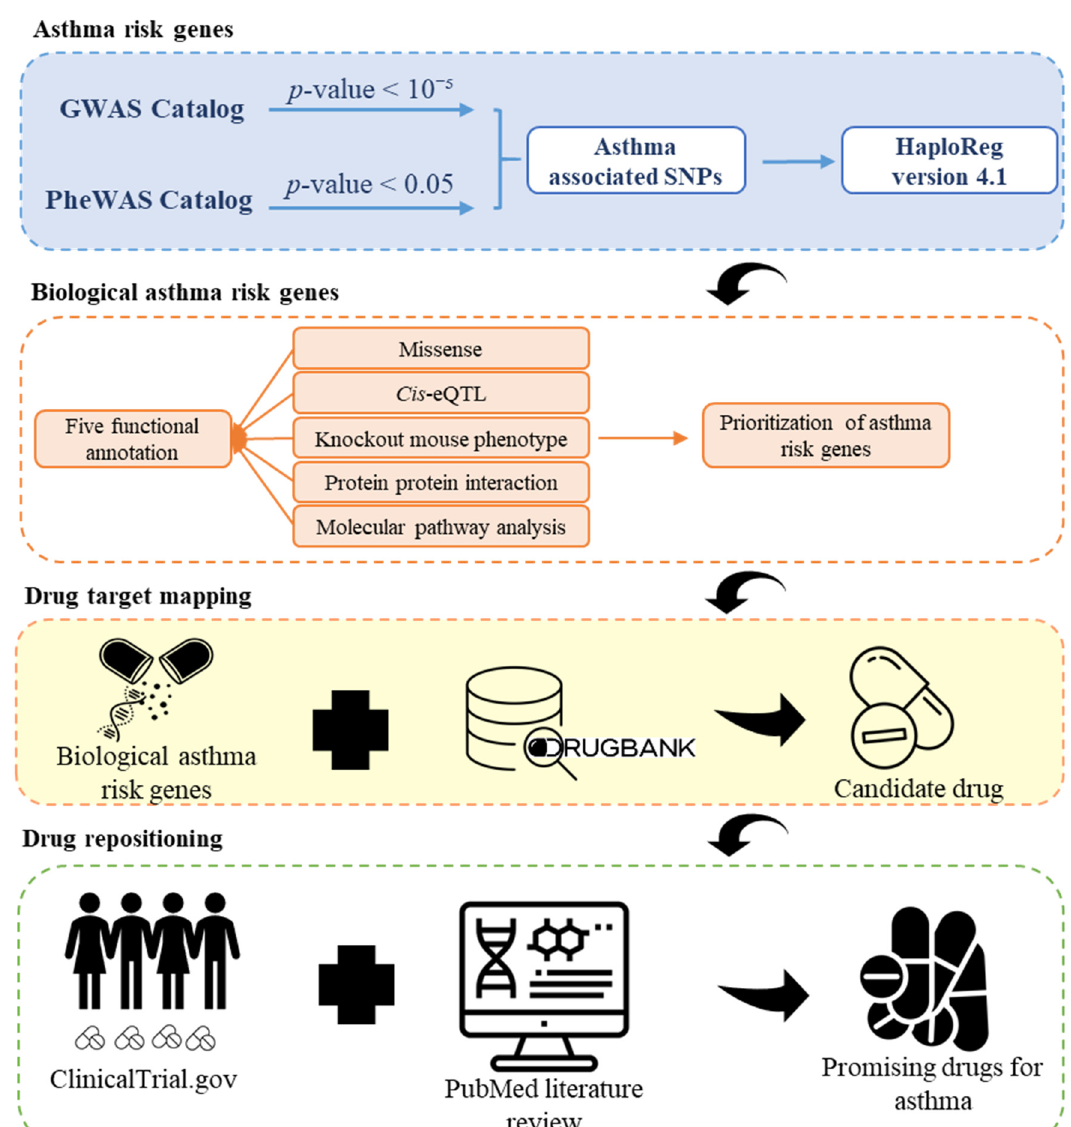
(scores ranged from 0 to 5 for each gene).